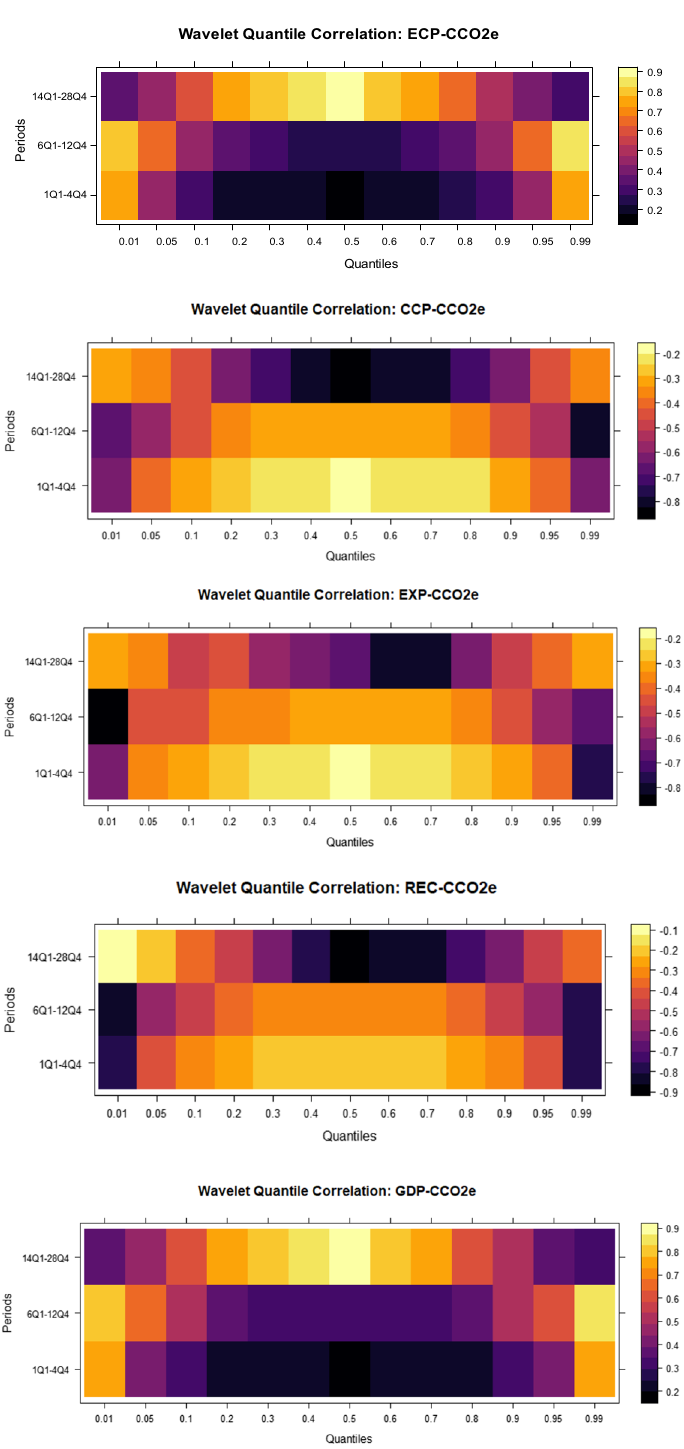
Fig. 8 WQC between CCO2e and modeled